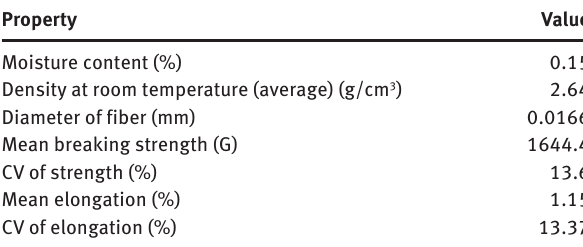
Table 1 Properties of basalt fiber.